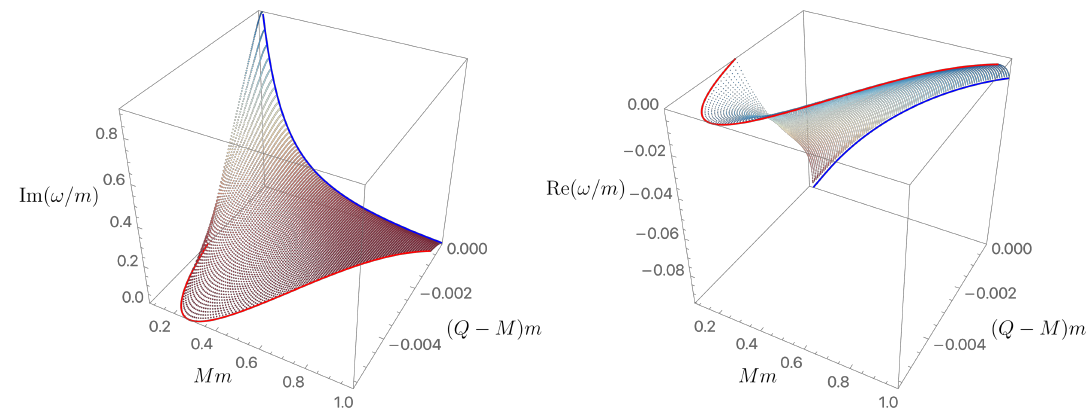
Figure 11 . Imaginary part (left panel) and real part (right panel) of ω as a function of mM and ( Q − M ) m for fixed α = 1 , q/m = 0 . 5 . The onset line, depicted in red, was computed directly with ω = 0 (see section 3.2), whereas the blue line at extremality, where M = Q , was computed using the method outlined in section